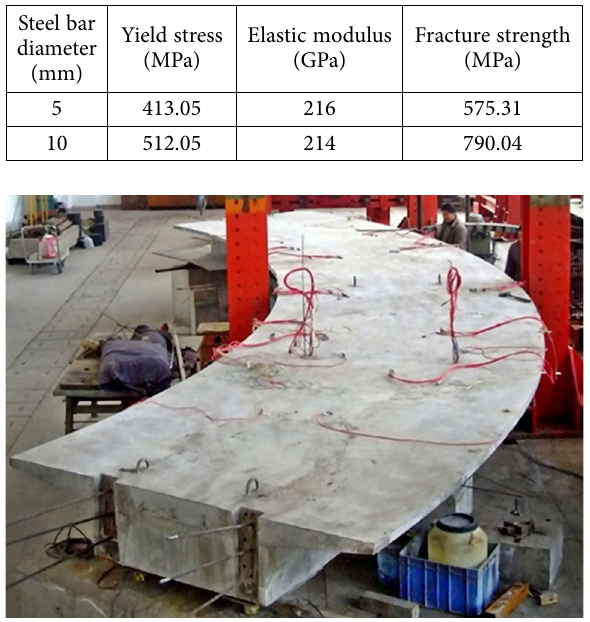
Figure 1. The large-curvature PCCBG bridge